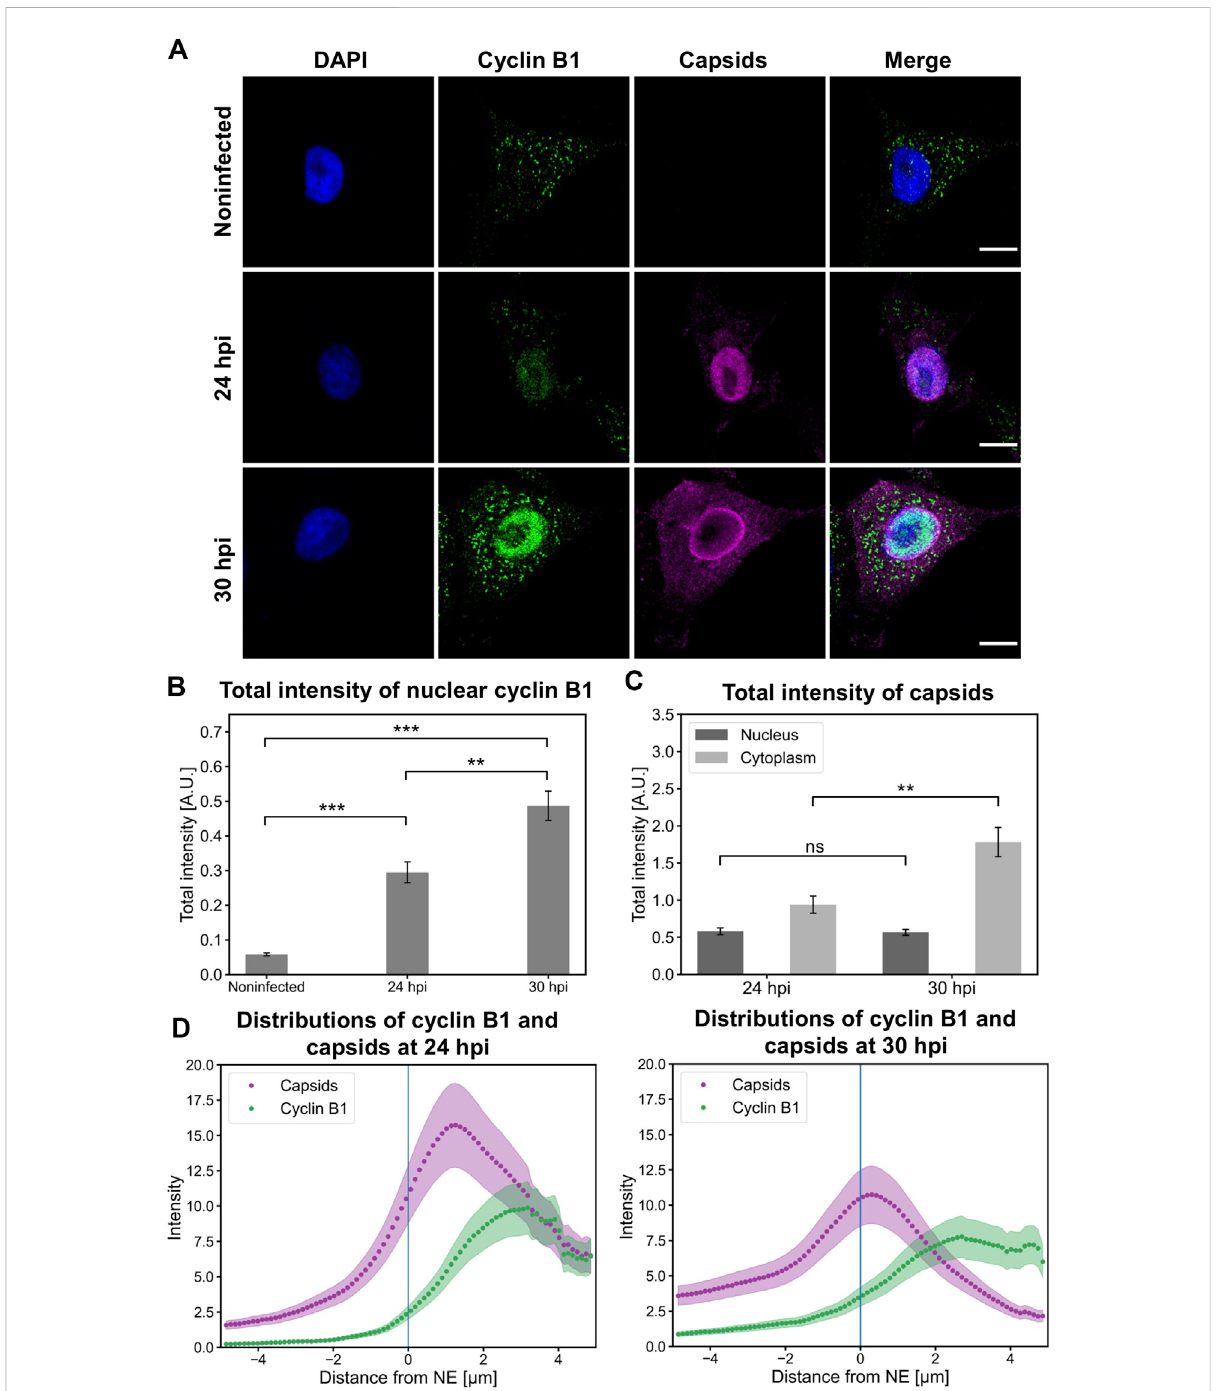
FIGURE 5 Nuclear accumulation of cyclin B1 is accompanied by the nuclear release of capsids. (A) Representative images showing the intracellular distribution of viral capsids and cyclin B1 in non-infected and infected NLFK cells at 24 and 30 hpi. The cells were immunolabeled with antibodies against cyclin B1 (green) and intact capsids (magenta). Blue corresponds to DAPI staining. Scale bars, 10 µm. (B) Total fl uorescence intensities of nuclear cyclin B1 in non-infected and infected cells at 24 and 30 hpi and (C) total fl uorescence intensities of capsids in the nucleus and the cytoplasm.The errorbarsshow thestandard errorofthemean. Statistical signi fi cances weredeterminedusing Games-Howelltest.Thesigni fi cance valuesshownaredenotedas***( p < 0.001)orns(notsigni fi cant)( n =28). (D) DistributionsofcyclinB1andcapsidsasafunctionofdistancefromthe NE (blue line) in infected cells at 24 and 30 hpi (n = 28). The shaded areas around the data points represent the standard error of the